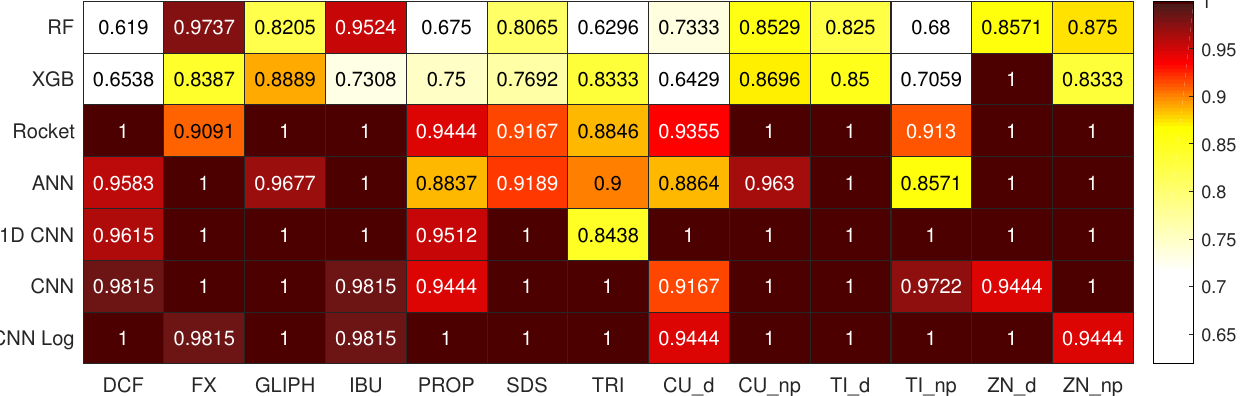
Figure 2. Heatmap depicting the accuracy per class of each best performing model when predicting the different types of ECs.